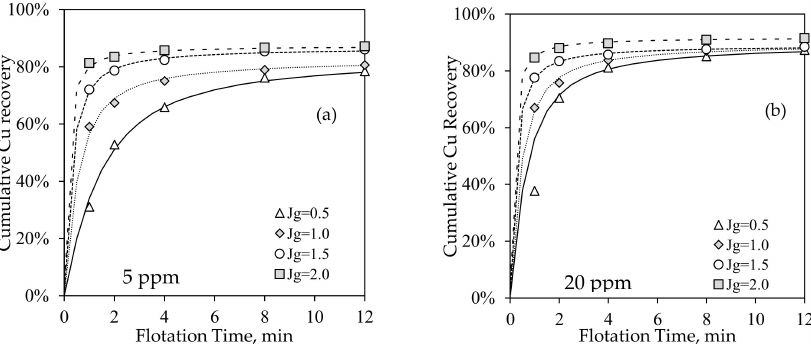
Figure 10. Batch flotation Cu recovery curves. ( a ) 5 ppm, ( b ) 20 ppm.